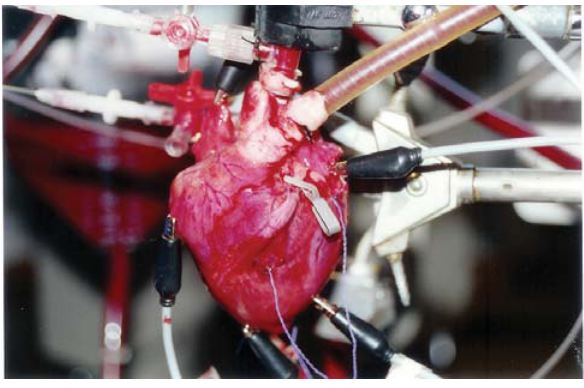
Fig. 2 - Coração isolado durante indução de isquemia regional. Cânula em VD, para coleta do efluente do seio coronário. Cristais piezoelétricos. Mini-pinça em artéria interventricular anterior. Linha de pressão em raiz da aorta, medindo a pressão de perfusão coronariana. Linha de pressão em AE, medindo a pressão correspondente à pré-carga. Probe para registro